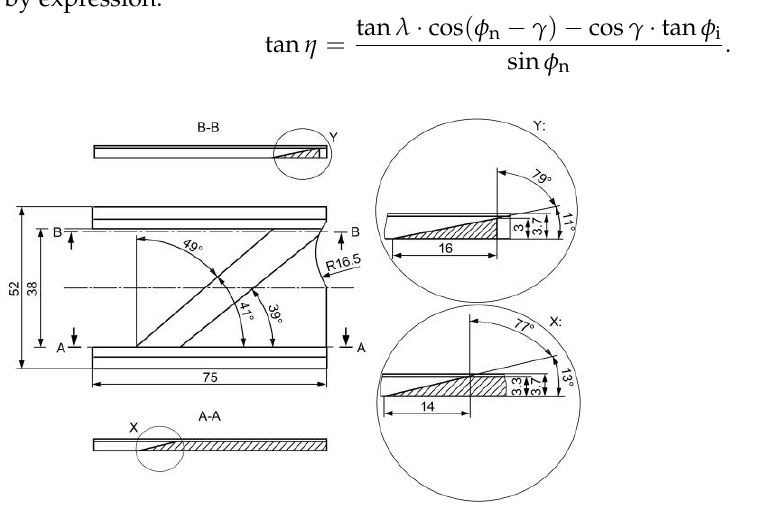
Figure 10. Detailed representation of the geometry of the proposed new grain-cutting knife design Figure 10. Detailedrepresentationofthegeometryoftheproposednewgrain-cuttingknifedesignsolution. solution.